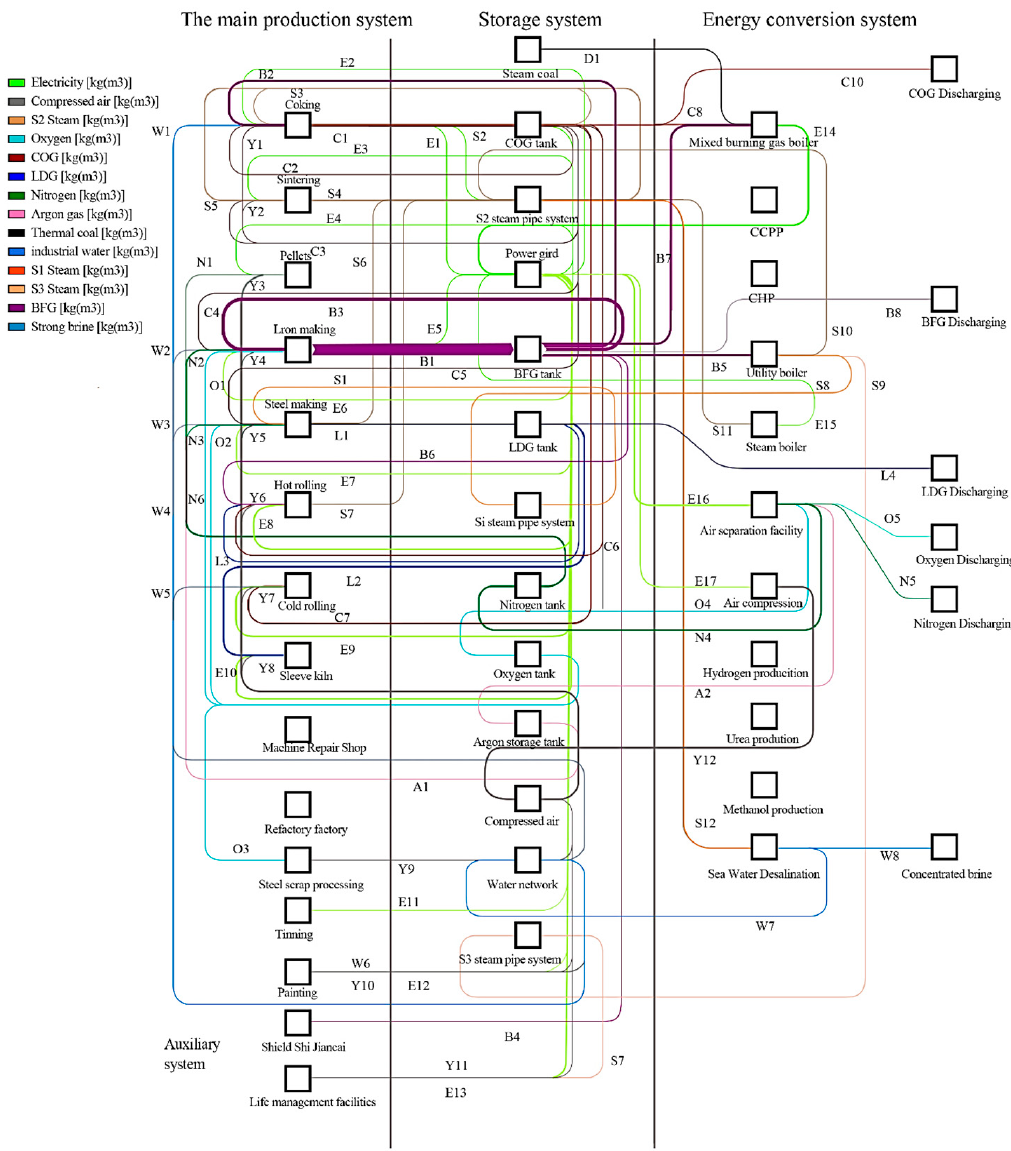
Figure 3. Network diagram of the actual energy system in the S steel plant.